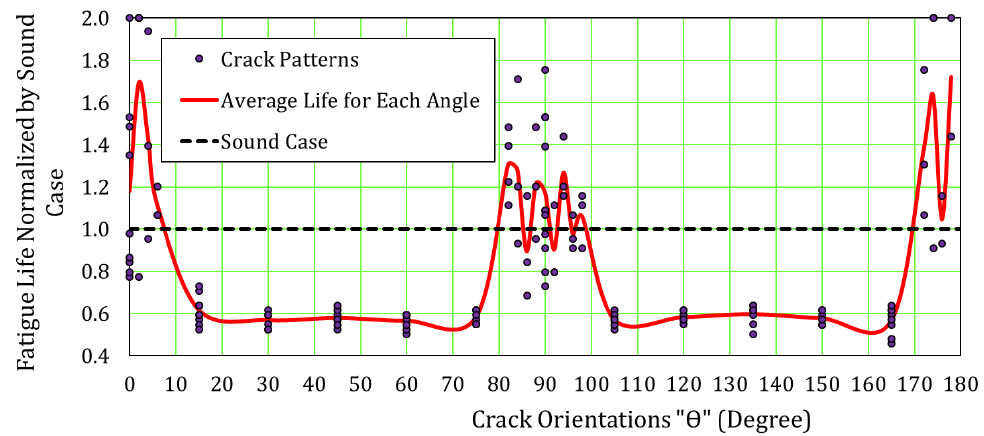
Figure 11. Relation of the average strain and the normalized fatigue life of the studied crack patterns.